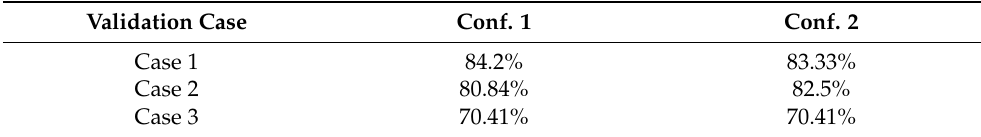
Table 6. Compliance with stability requirement: % of total